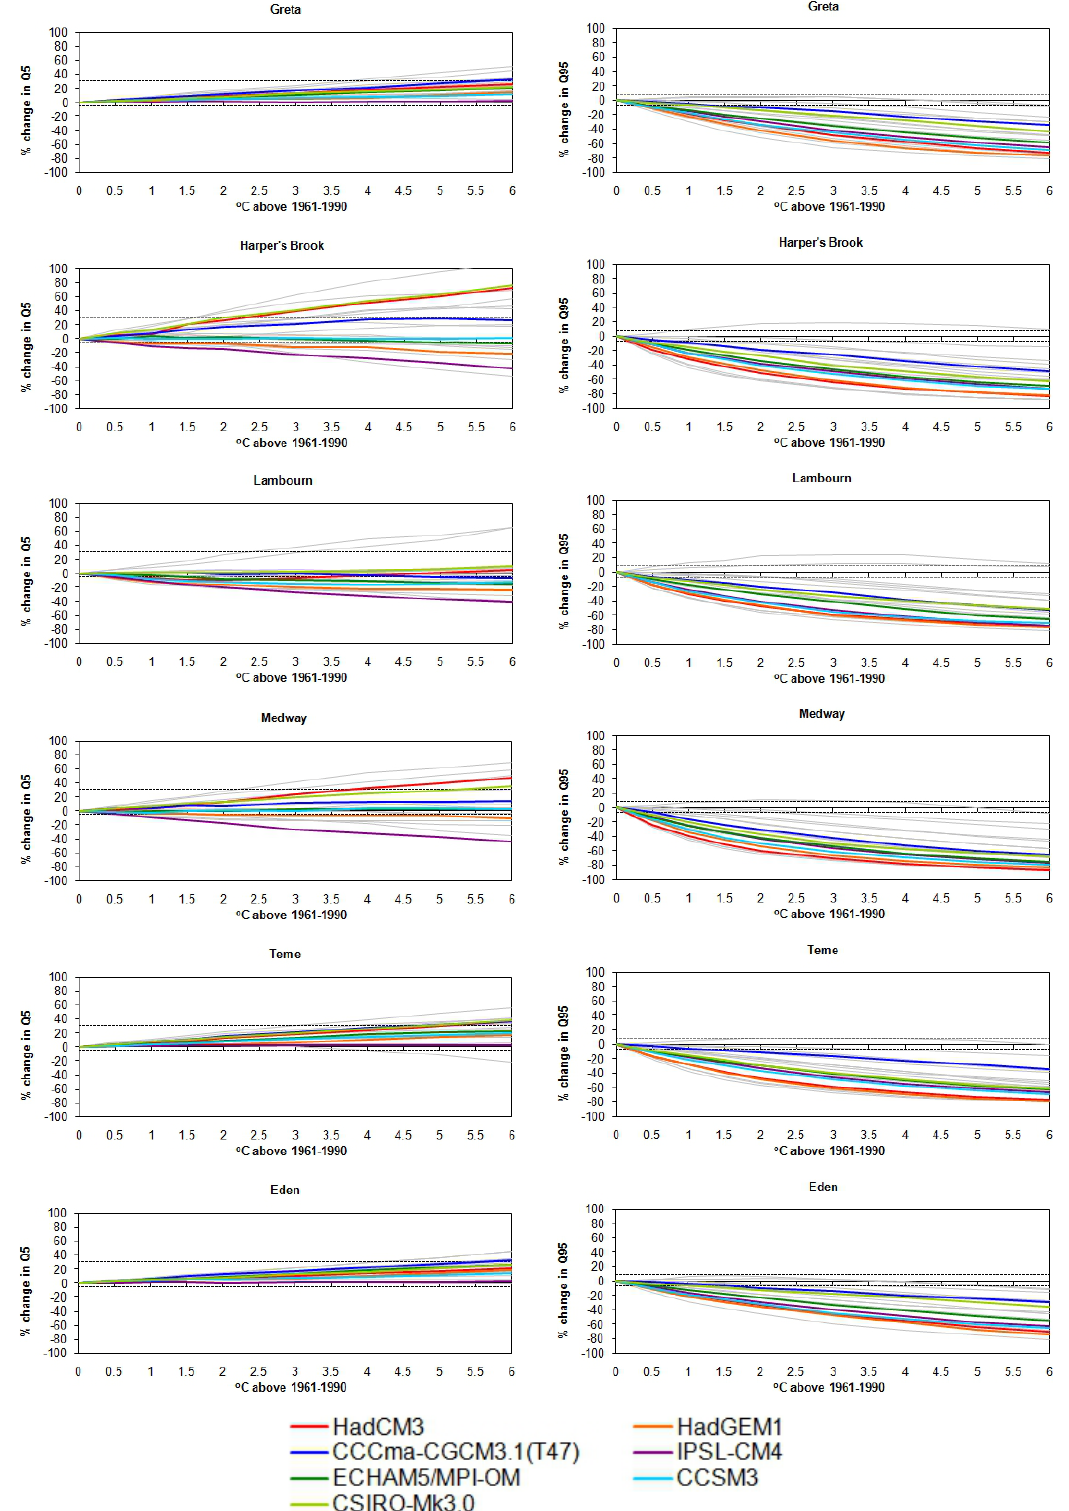
Fig. 6. Change in Q95 and Q5 in each catchment. The seven priority climate model patterns are highlighted.